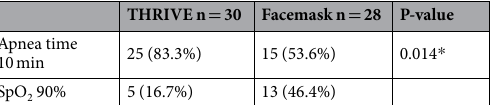
Table 2. Termination criteria in the THRIVE group and the facemask group. Data are given as n (%). THRIVE, transnasal humidified rapid insufflation ventilator exchange. * Statistically significantly different from the facemask group, P < 0.05.